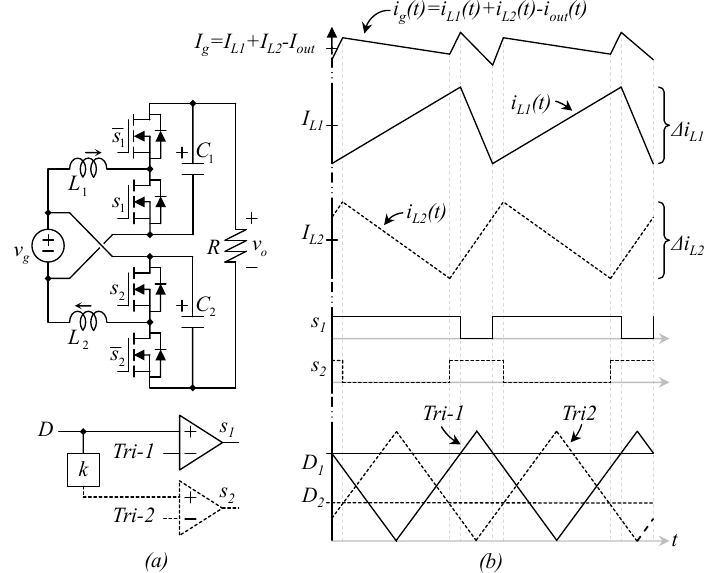
Figure 9. The DDBC during a non-zero input current-ripple operation, with the PWM strategy studied in [4] ( a ) PWM block diagram and circuit schematic, and ( b ) important waveforms of the PWM strategy and the circuit operation.